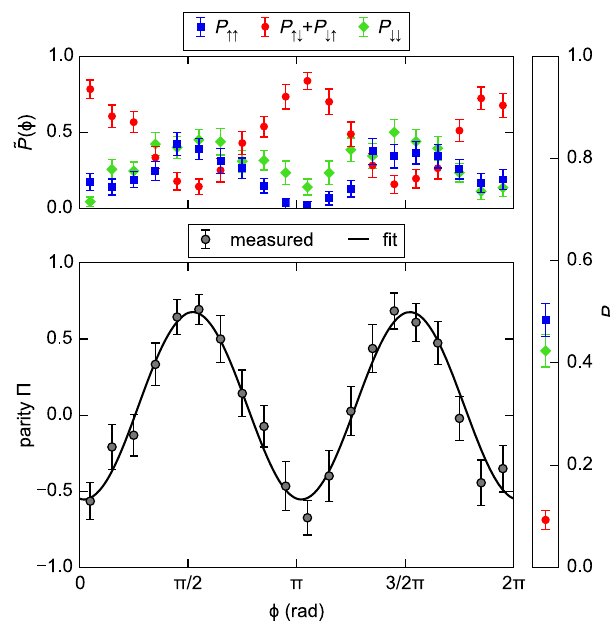
TABLE I. Sources of error for the experimental fidelity of the j Φ − i state created by the entangling gate operation. Given values are the absolute decrease in fidelity due to each effect if all other influences are kept constant. The effects are not independent, FIG. 2. Parity oscillations and populations of the entangled which has to be taken into account if multiple error sources are state produced by the gate and a subsequent π = 4 rotation. The ~ P ~ P ~ P ~ P populations ↑↑ (blue squares), ↑↓ þ ↓↑ (red circles), and ↓↓ (green diamonds) oscillate as a function of the phase of the analysis pulse ϕ , which is scanned from 0 to 2 π . They yield the parity Π ð ϕ Þ , which we fitted with a sine of variable offset, phase, and amplitude. The values for the populations P on the right-hand side come from a measurement without an analysis pulse. The overlap with the maximally entangled state j Φ − i inferred from this data is F ¼ 76 ð 2 Þ % . Error bars are statistical standard deviations of the mean within each bin. The slight offset in the phase is due to a residual two-photon Raman-laser detuning of (cid:3) 3 kHz.